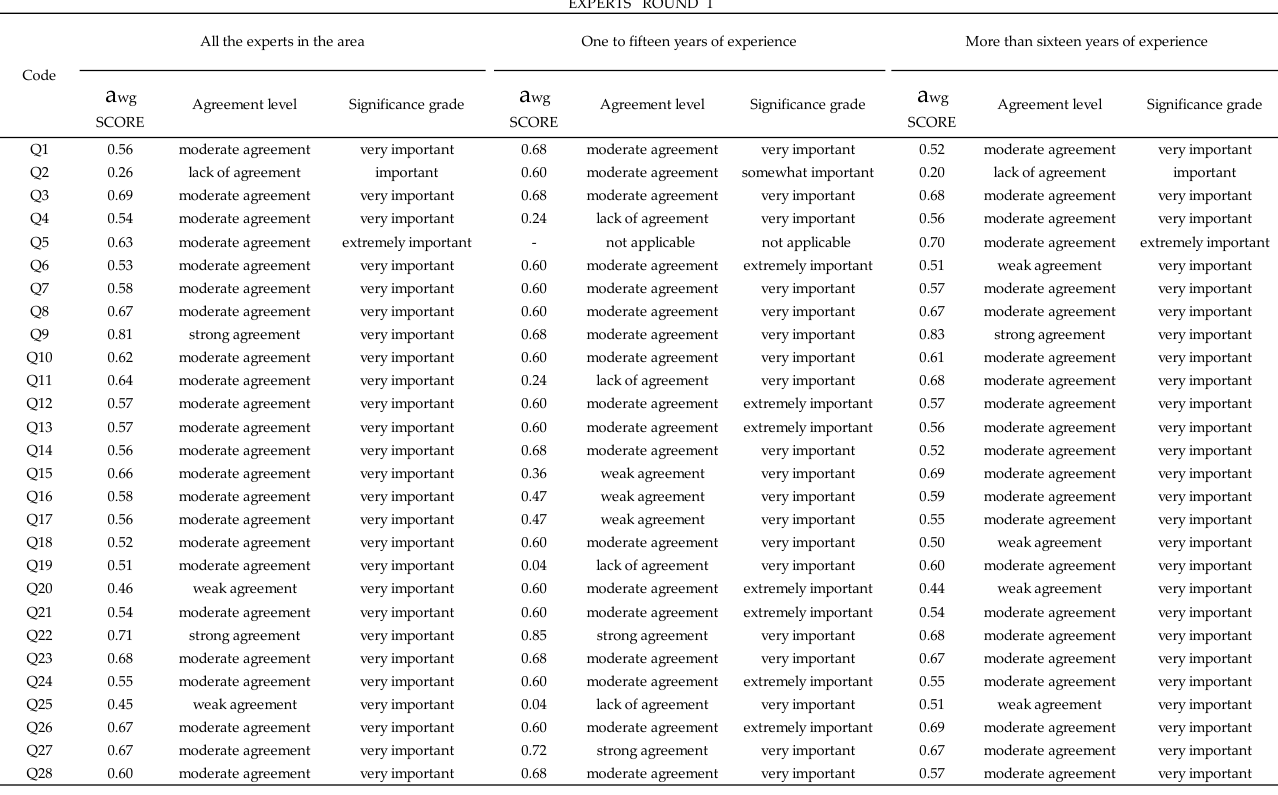
Figure 5. Importance rating and IRA analysis of the factors (benefits) of the first round of experts.